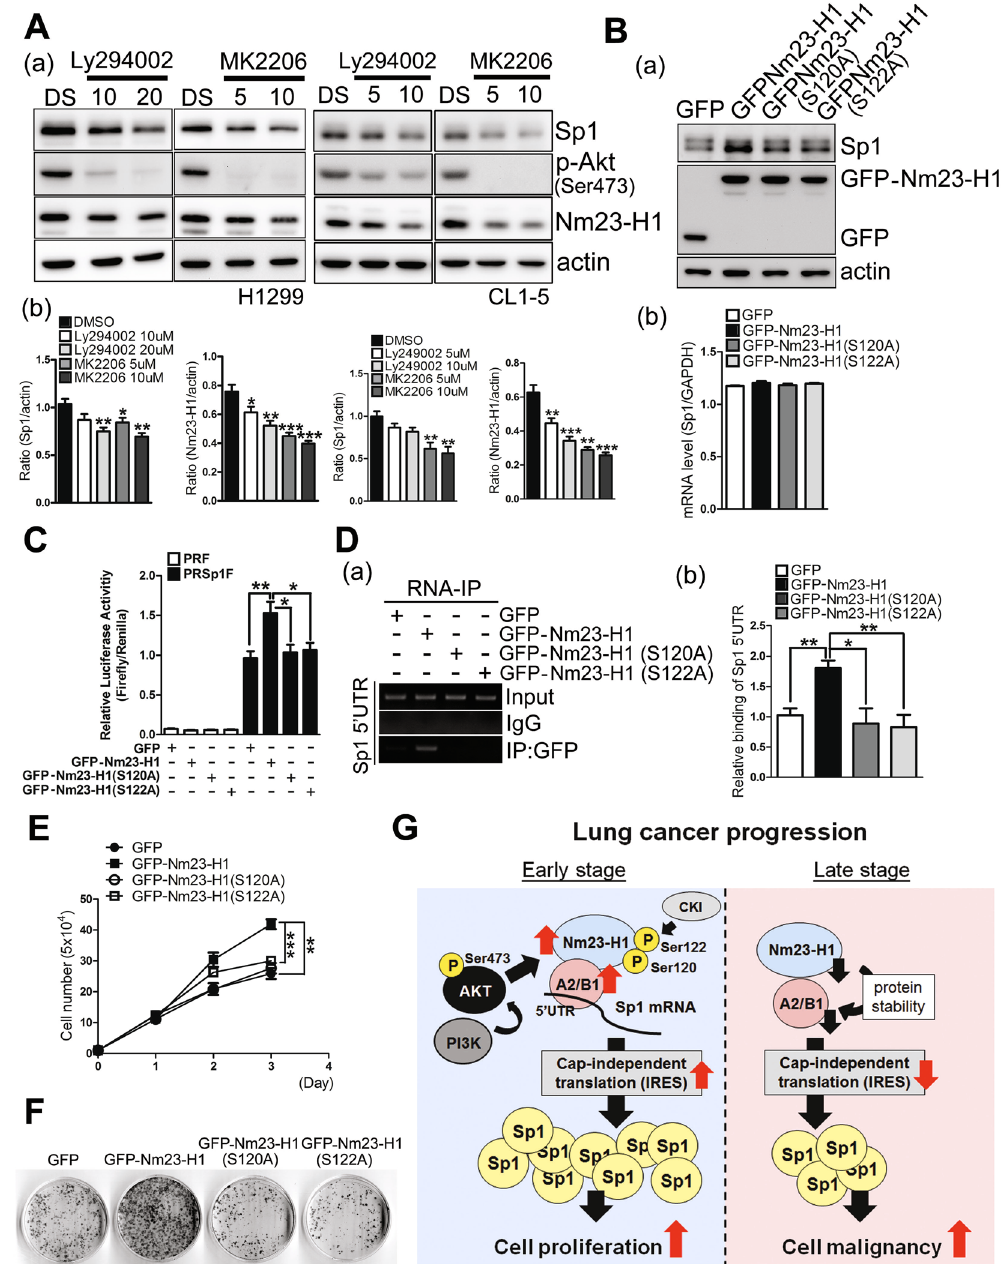
Figure 8. Akt activation might be involved in the Nm23-H1-mediated IRES-translational activity of Sp1 mRNA. ( A ) Samples were harvested from H1299 and CL1-5 cell lines treated with Akt inhibitors, Ly294002 and MK2206, and were analyzed by Western blotting with antibodies against the indicated proteins (a). After three independent experiments, the proteins levels were quantified and statistical analysis was done with a t-test, * p < 0.05; ** p < 0.01; *** p < 0.005 (b). ( B – F ) Samples harvested from H1299 cells with overexpression of GFP, GFP-Nm23-H1, GFP-Nm23-H1(S120A) or GFP-Nm23-H1(S122A) were analyzed by Western blotting with antibodies against the indicated proteins and real time PCR ( B ), 5 ′ UTR-driven luciferase activity ( C ), RNA-IP with anti-GFP antibodies ( D ), cell counting ( E ) and a colony-formation assay ( F ). After three independent experiments, the proteins levels were quantified and statistical analysis was done with a t-test, * p < 0.05; ** p < 0.01; *** p < 0.005. ( G ) The proposed model shows that Nm23-H1 positively regulates Sp1 expression through an increase in its translational activity in a cap-independent